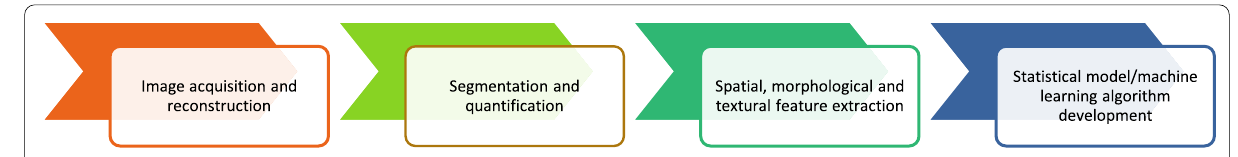
Fig. 3 List of factors that affect radiomics feature analysis of lung